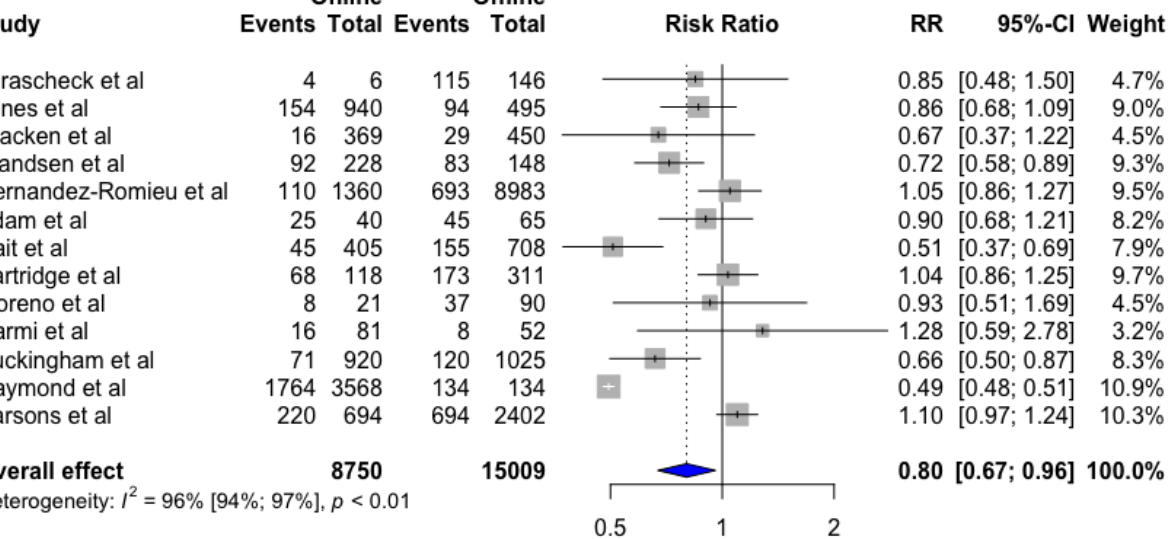
Figure 4. Conversion rate for online and offline recruitment. Value <1, in favor of offline recruitment; value >1, in favor of online